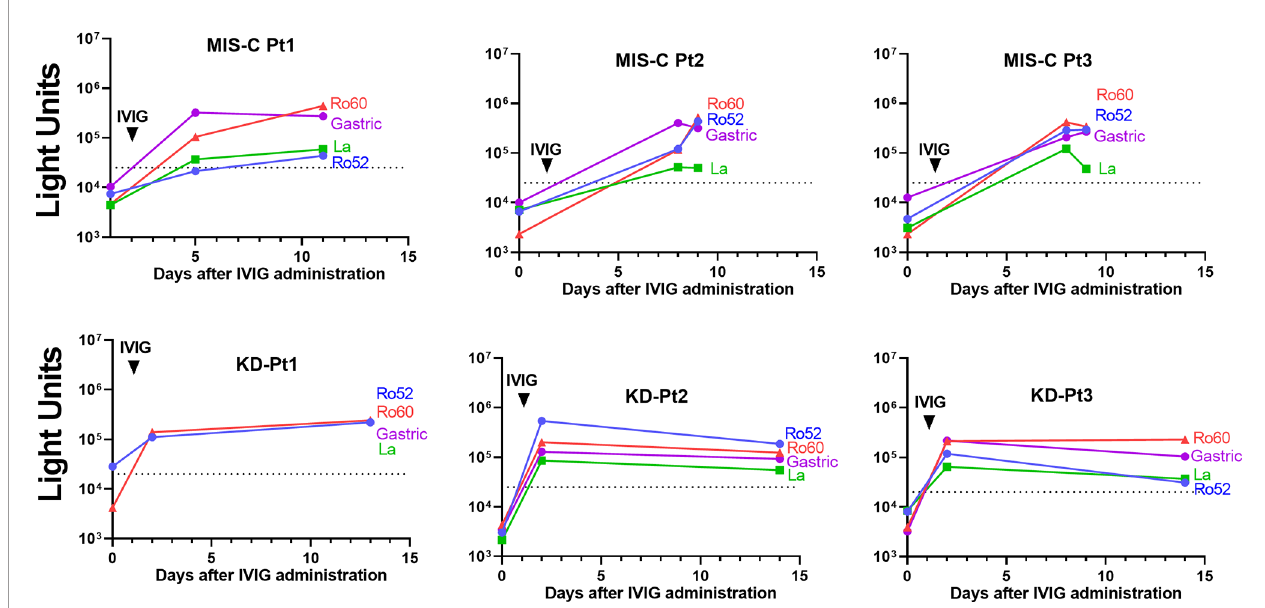
FIGURE 4 | Longitudinal autoantibody pro fi les before and after administration of IVIG in MIS-C and KD patients. Antibody levels were determined in serial samples from representative MIS-C (MIS-C, Pt1-3) and KD patients (KD, Pt1-3), in which time zero represents the day of hospital admission. The autoantibody pro fi les for Ro52 (blue), Ro60 (red), La (green), and gastric ATPase (purple) are shown by the colored lines, in which the cut-off value for determining positivity is shown by the dotted lines. The arrow shows the day when IVIG was